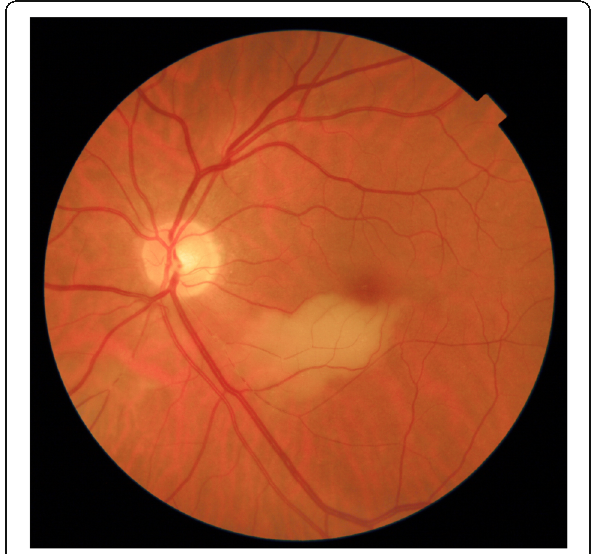
Fig. 10 Yellow-white zone of retinal infarction (case